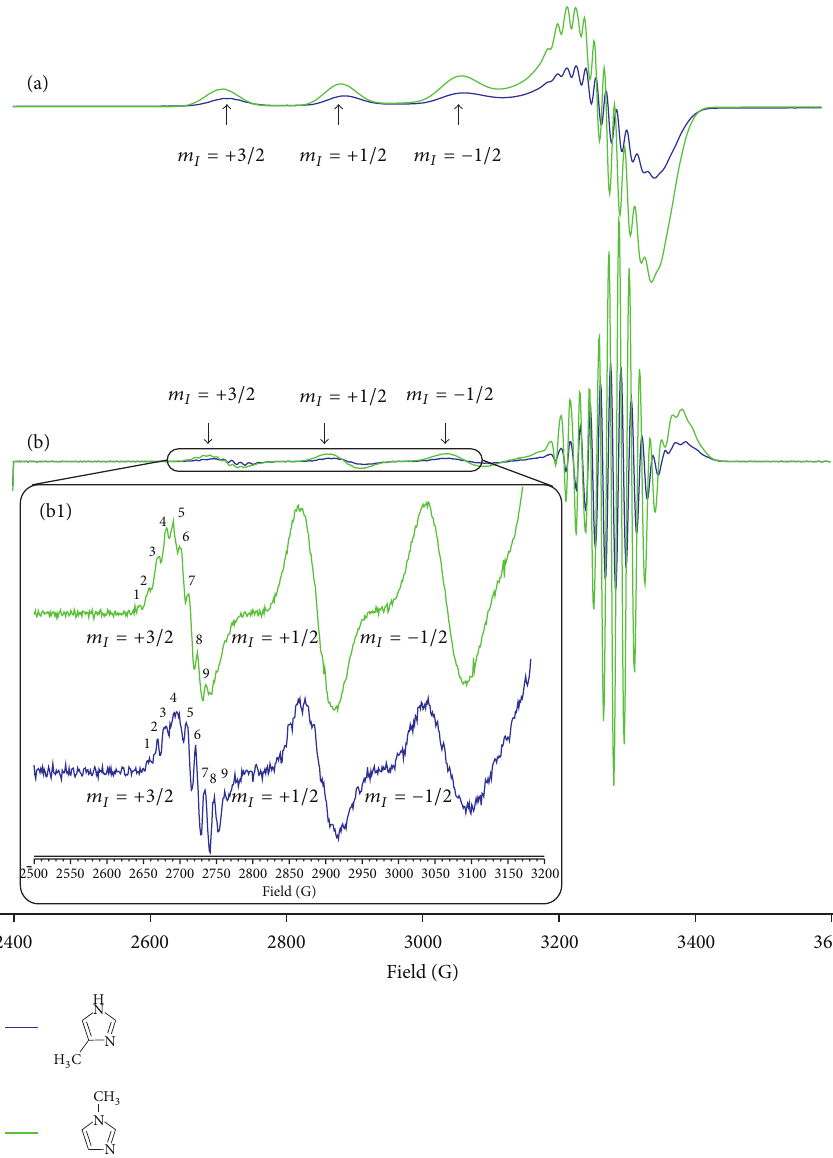
Figure 8: Me-Im in water/glycerol. (a) EPR signal of Me(1)-Im (green) and Me(4)-Im (blue). (b) Derivative of the EPR signal with inset (b1) displaying the fine structure at 𝑚 𝑙 = +3/2 [38]. The fine structure indicates four equivalent ligands. However, some signals appear to be doublets which may be explained by the Cu 2+ isotope mixture [79,